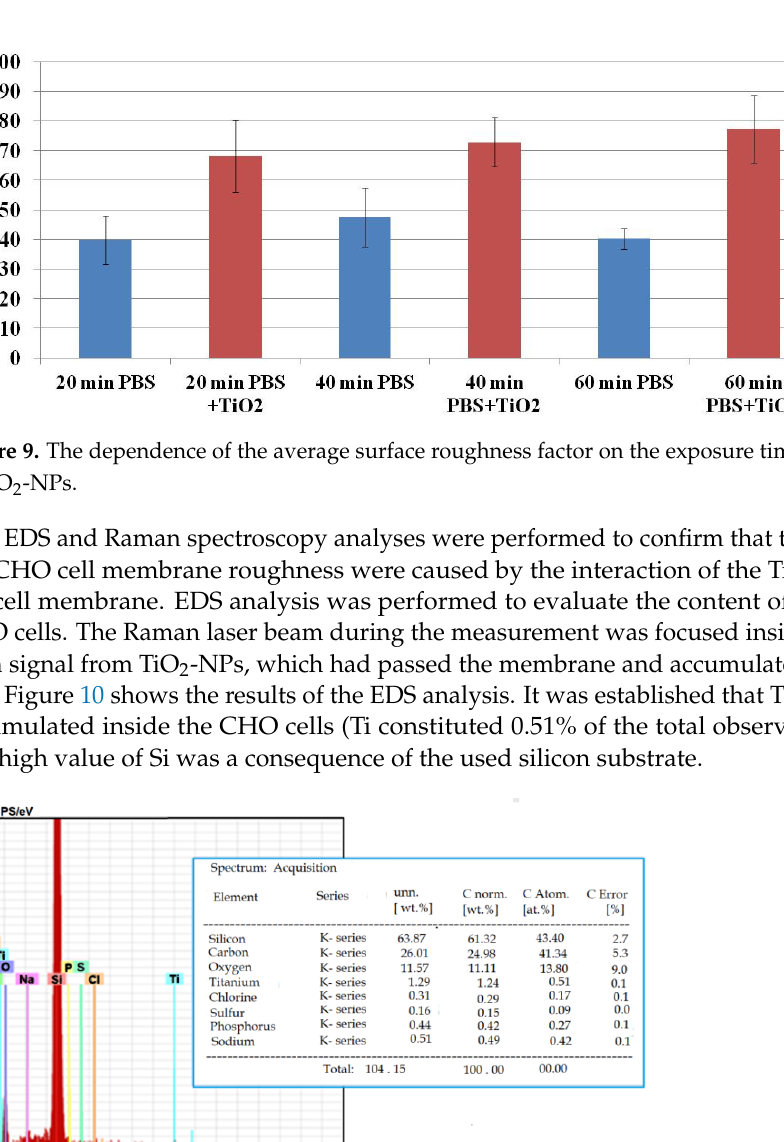
Figure 8. The dependence of the 10-point height ( S z) surface roughness factor on the exposure time of CHO cells to TiO 2 -NPs.